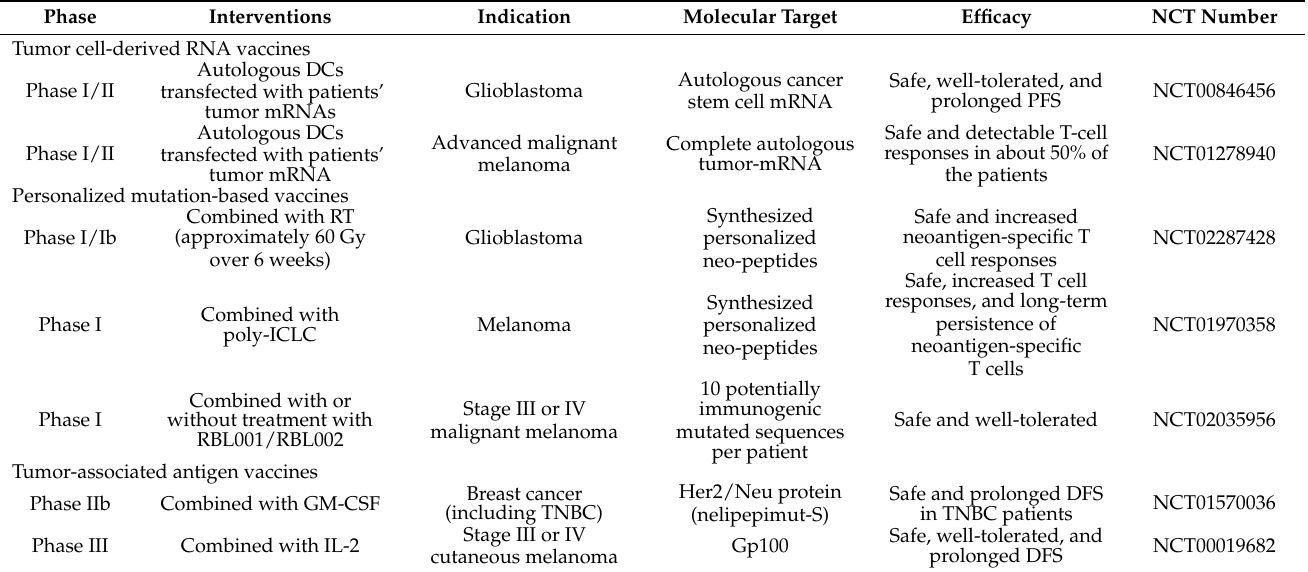
Table 1. Selected cancer cell-based vaccines achieved to clinical trials. DCs, dendritic cells; PFS, progression-free survival; GM-CSF, granulocyte macrophage-colony stimulating factor; TNBC, triple negative breast cancer; DFS, disease-free survival; RT,